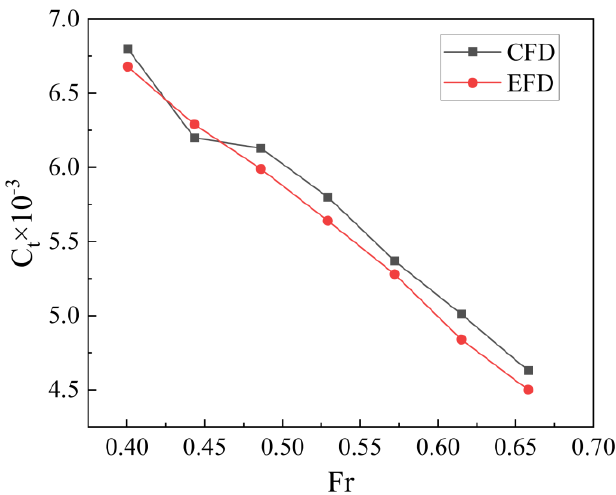
Figure 7. Comparison of CFD and EFD results for warp-chine pentamaran model.